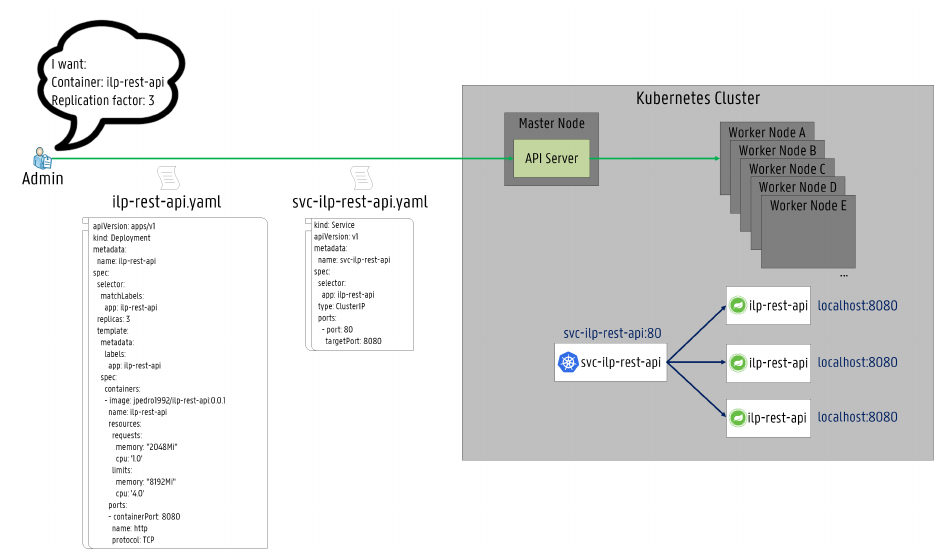
Figure 8. The detailed service scheme of the ILP REST API in the Kubernetes platform.